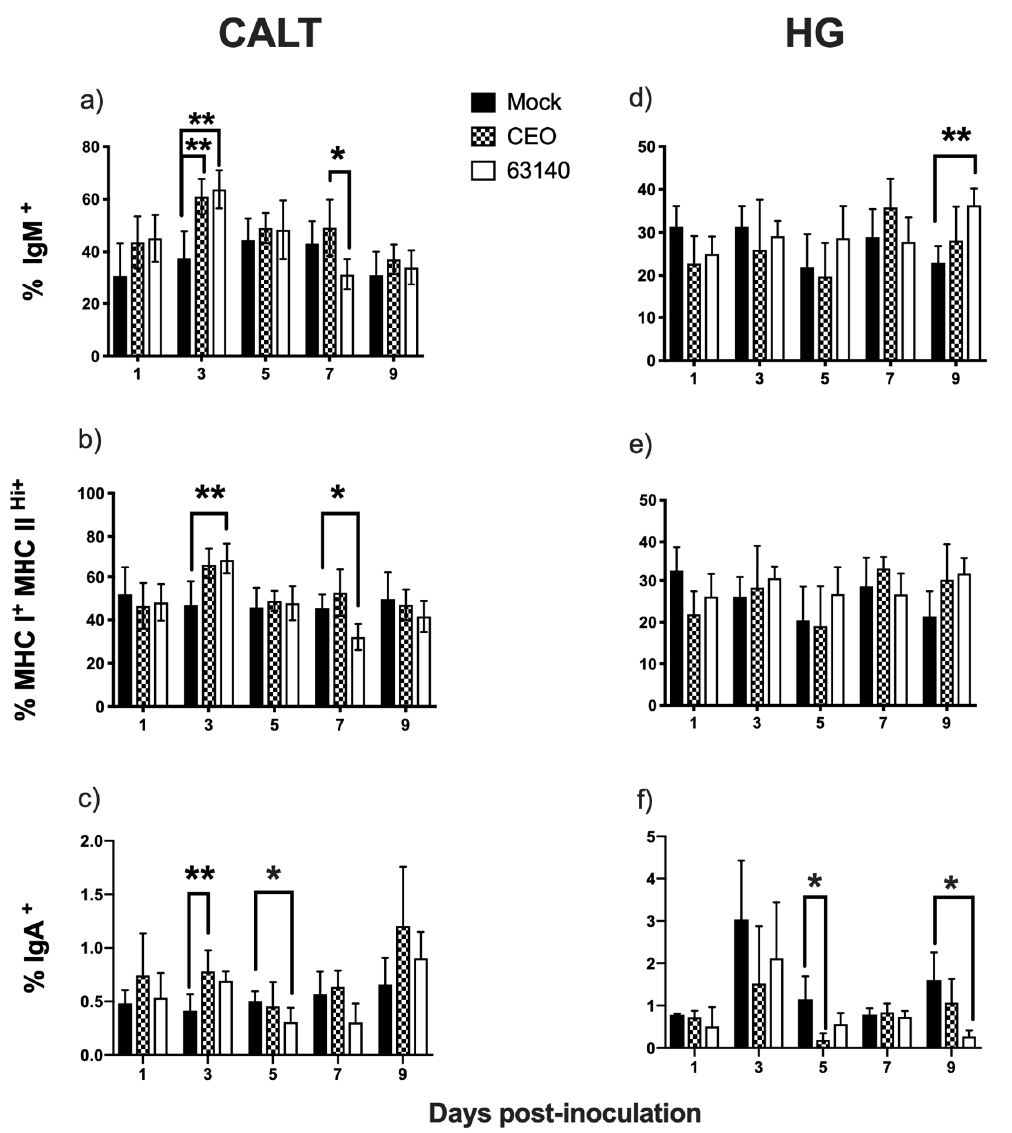
Figure 4. Percentages of IgM + , MHCI + / MHCII Hi + and IgA + cells in the conjunctiva-associated lymphoid tissue (CALT) and Harderian gland (HG) of chickens inoculated with the CEO vaccine strain and virulent 63140 strain. Percentage of IgM + ( a , d ), MHCI + / MHCII Hi + ( b , e ), and IgA + ( c , f ) cells in CALT 1 to 9 days post-CEO ( a – c ) and 63140 ( d – f ) inoculation. The one-way analysis of variance Kruskal– Wallis test and the Dunn´s multiple comparison post-test ( p ≤ 0.05) were performed to individually compare IgM + , IgA + and MHCI +/ MHCII Hi+ percentages in CALT and HG for mock-, CEO-, and 63140- inoculated groups. The mean percentage is indicated by bars and vertical lines represent the standard deviation (SD). Significant increase in IgM + , MHCI + /MHCII Hi+ , and IgA + cells is indicated by (**), and significant decrease by (*) ( p ≤ 0.05).